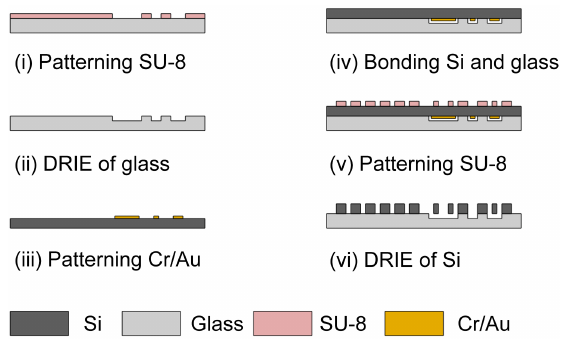
Figure 4. Fabrication process of microfluidic chip: ( i ) To make a clearance pattern between glass substrate and movable part of Si layer, SU-8 is patterned onto a glass substrate as the etching mask for reactive-ion etching (RIE); ( ii ) RIE of the glass substrate is performed to a depth of 10 μm; ( iii ) A Cr/Au layer is patterned by lift off process as an etch stop layer. Cr/Au is deposited by sputtering; ( iv ) The clearance-patterned glass substrate is bonded to the Cr/Au patterned Si substrate by plasma activated bonding. Both substrates are treated with O 2 and N 2 plasma prior to bonding. After that, these substrates are bonded together and applied 700 V DC voltage; ( v ) SU-8 is patterned on the Si substrate as the etching mask for deep RIE (DRIE); ( vi ) The micropillar array, mechanical probe and force sensor are fabricated by DRIE of the Si substrate, followed by etching of the Cr/Au layer.